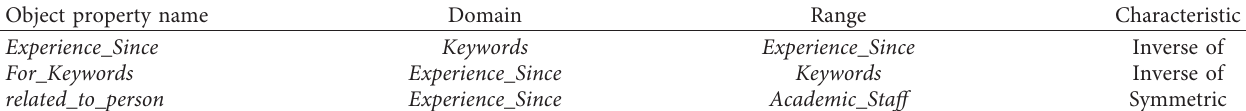
Figure 8: The result of the research interests, certification and trainings, academic and professional experiences, and publications query. Table 8: The properties used for the ranking of the faculty members.